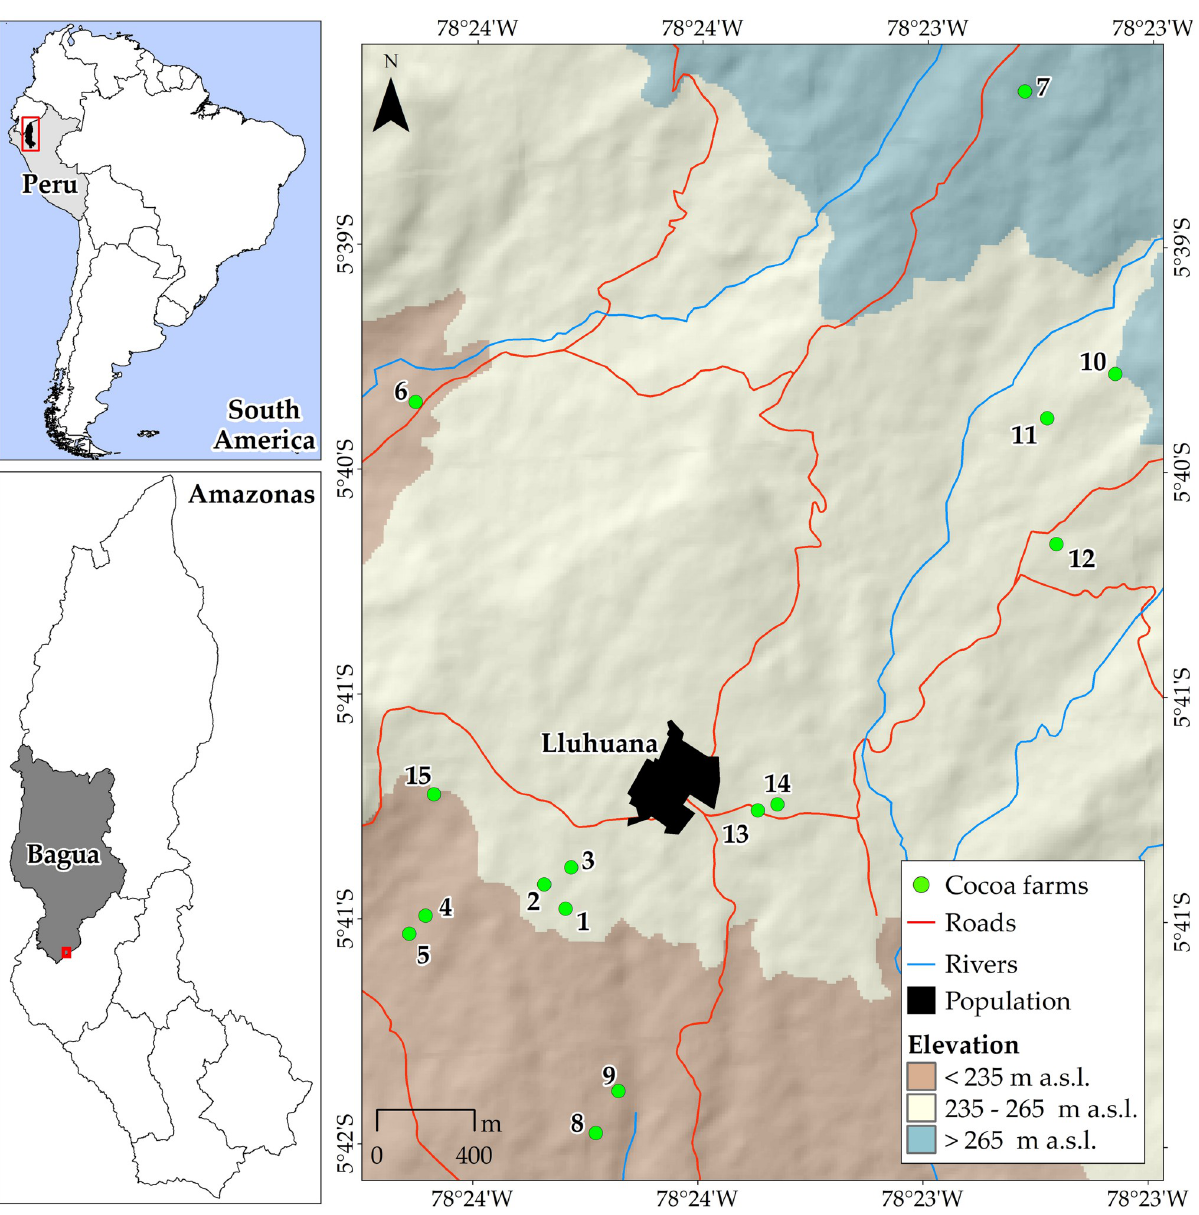
Fig 1. Plot location map. Map prepared by the authors based on open access resources: political-administrative boundaries from geoBoundaries [15], local details of ARA-Amazonas (http://visor.regionamazonas.gob.pe/indexv.php) and ALOS PALSAR digital elevation model (https://search.asf.alaska. edu/#/), 28 of June